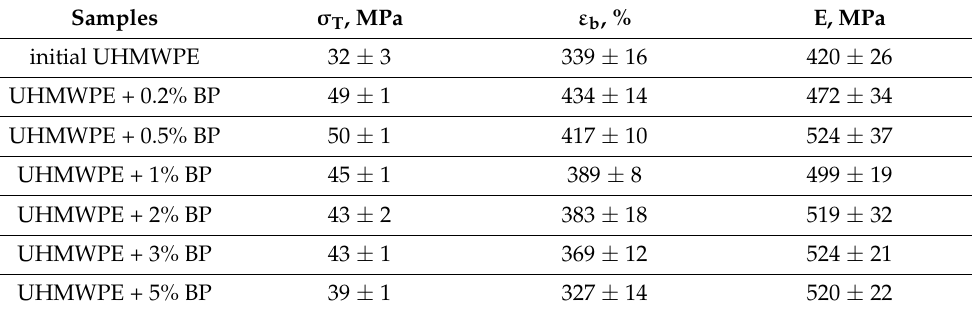
Table 3. Elongation at break, tensile strength, and Young’s modulus of UHMWPE and PCM with borpolymer (BP).